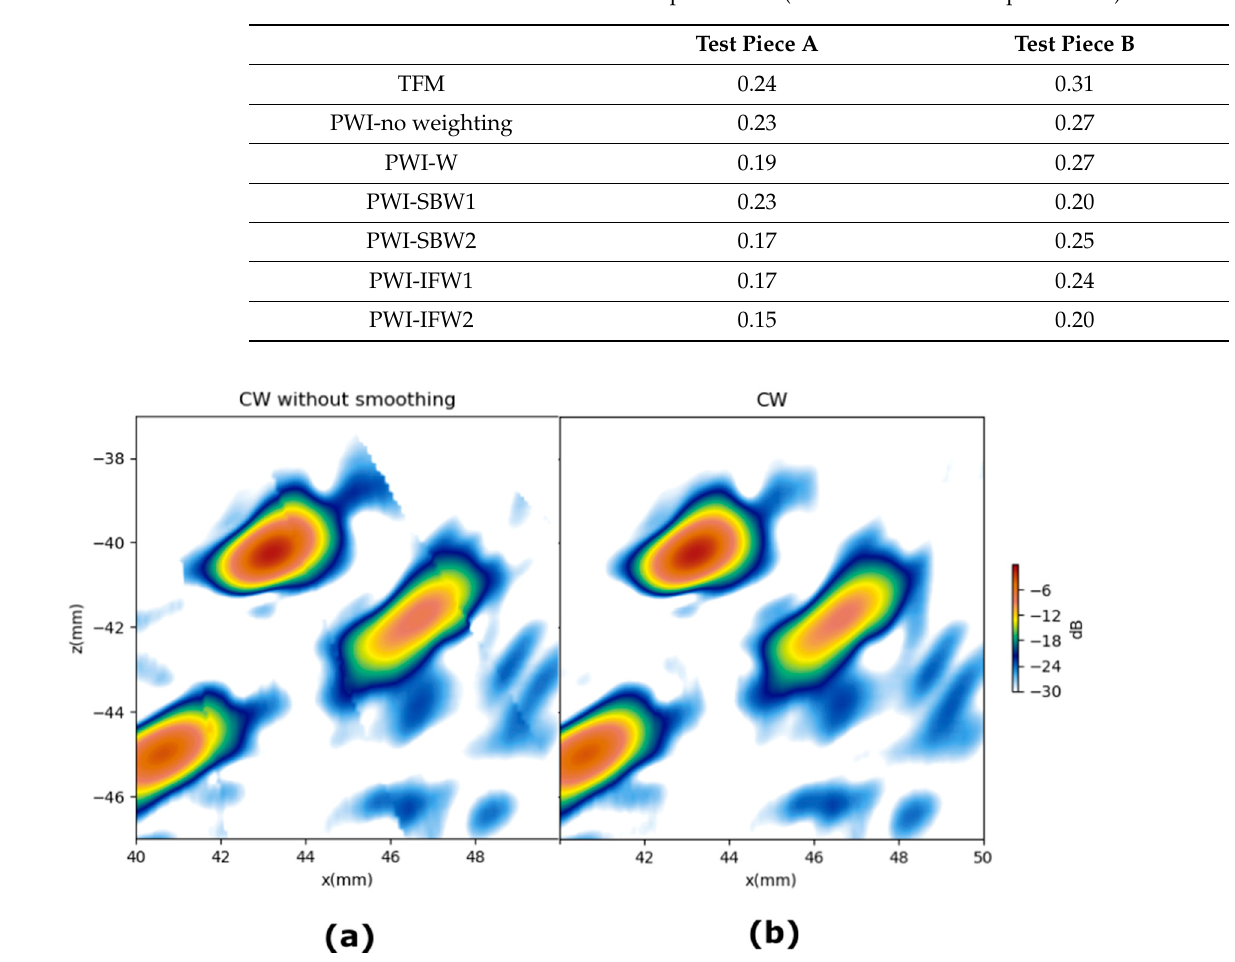
Table 1. Standard deviation of indications peak value (fraction of maximum peak value).